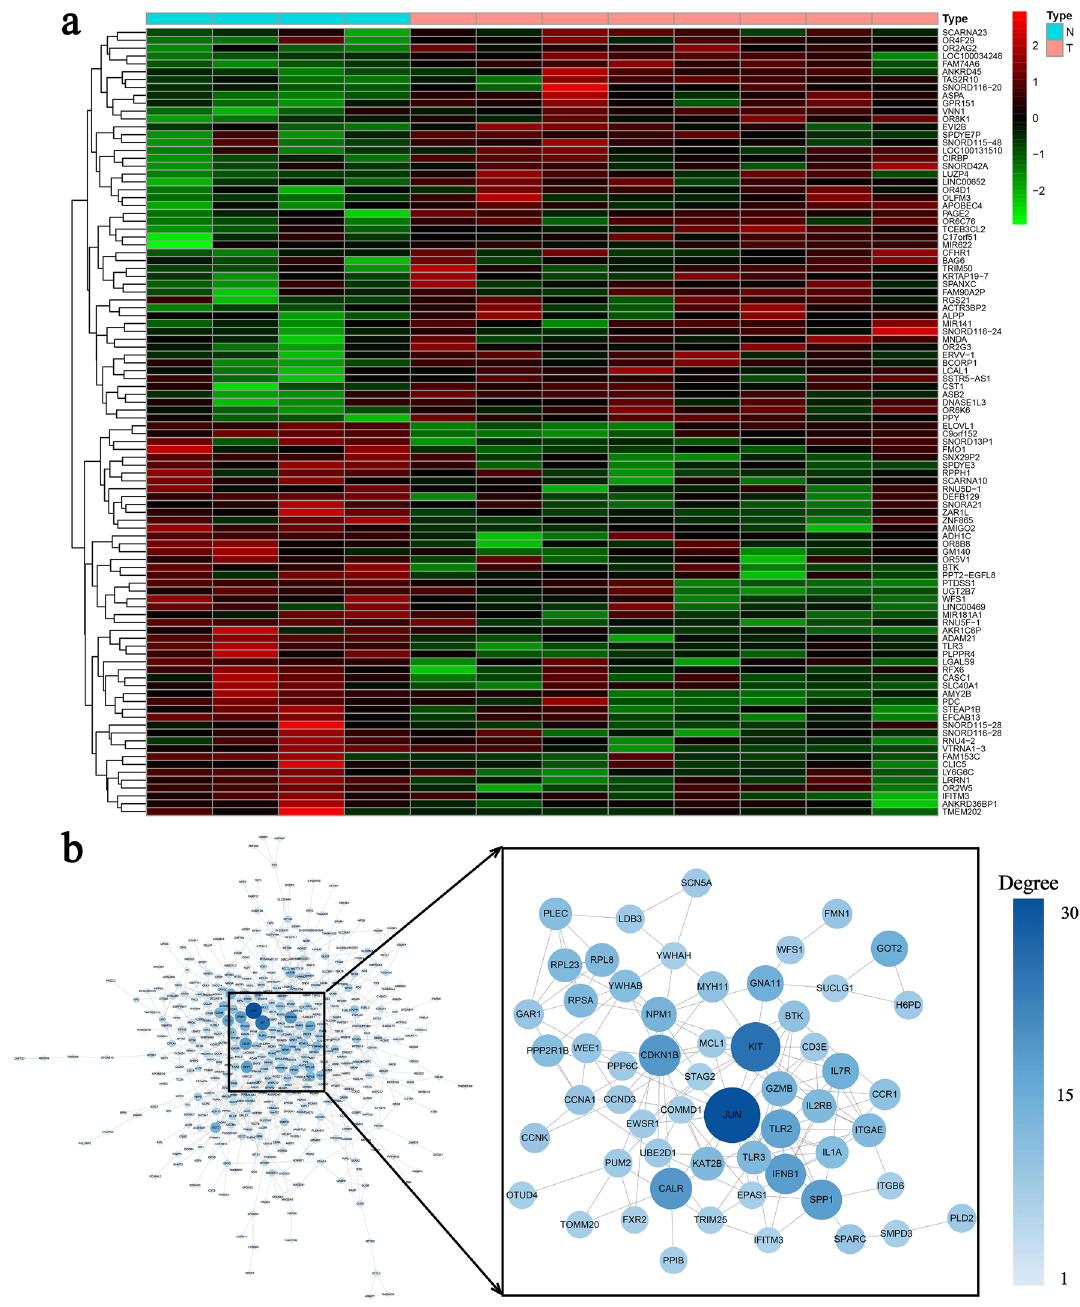
Figure 5. Heat map and PPI network. ( a ) Heat map of the 12 samples. Each column represents a sample, and each row represents one of the differentially expressed genes. ( b ) PPI network of